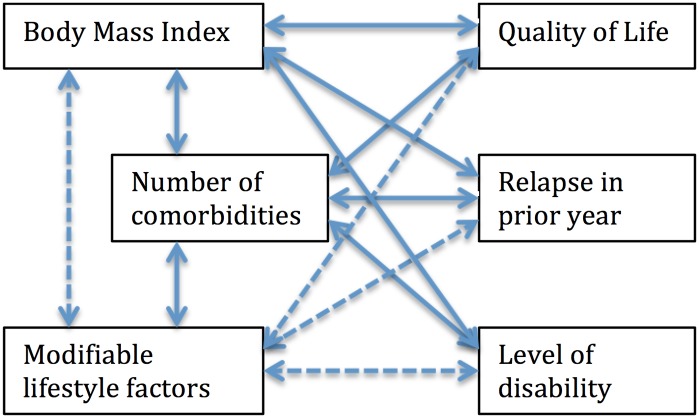
Associative conceptual model.